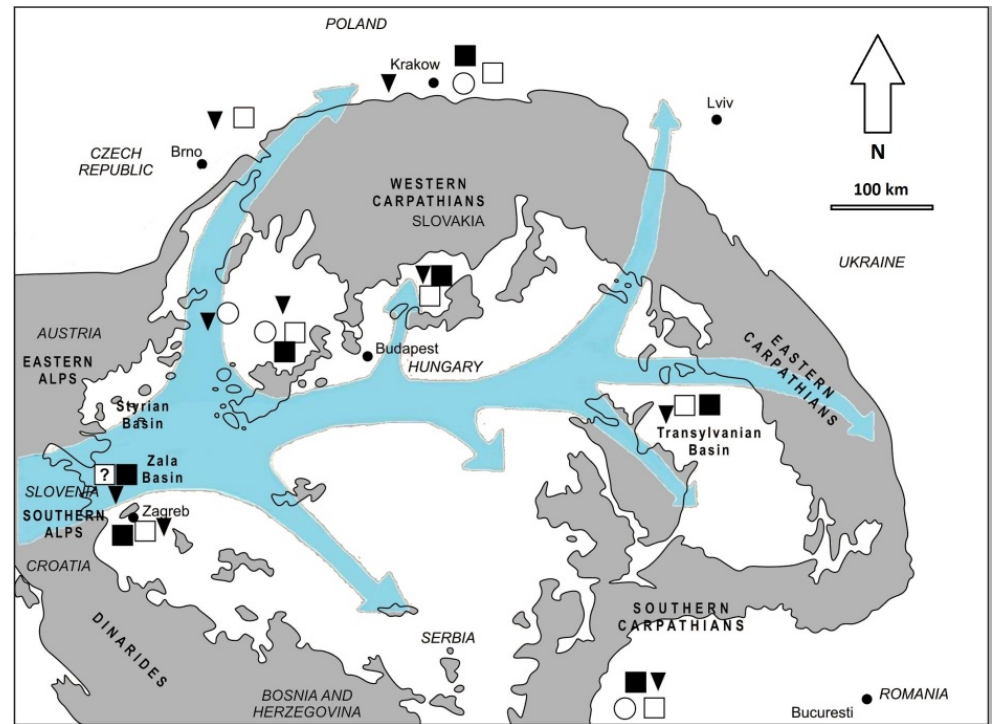
Figure 19. Distribution of pteropods: Clio fallauxi (Kittl, 1886) (white rectangulars), Clio pedemontana (Mayer, 1868) (black rectangulars), Vaginella austriaca Kittl, 1886 (black triangels) and Limacina valvatina (Reuss, 1867) (white circles), during the Early − Middle Badenian sensu [25] in the Paratethys. For references and localities see [59]. Paleogeographic map after [2].